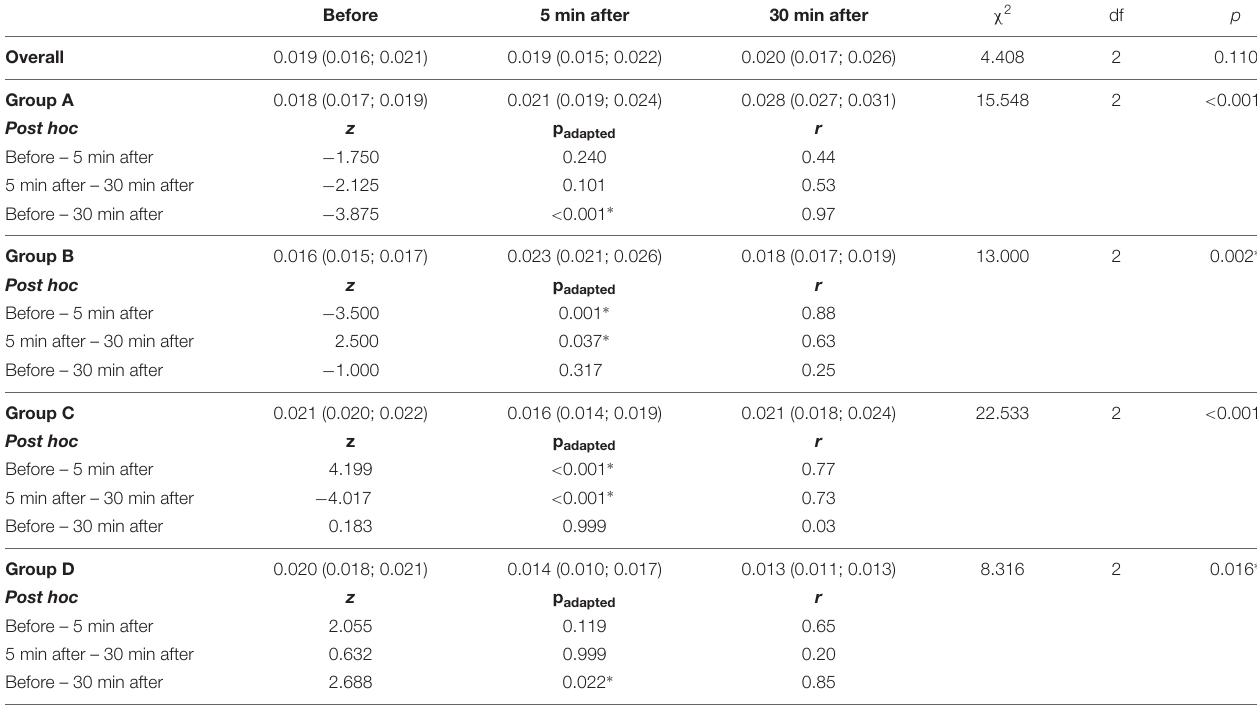
TABLE 2 | Comparison of recruitment curve slopes for before, 5 min after, and 30 min after paired associative stimulation over all the participants and for the four different response groups. Before 5 min after 30 min after χ 2 df